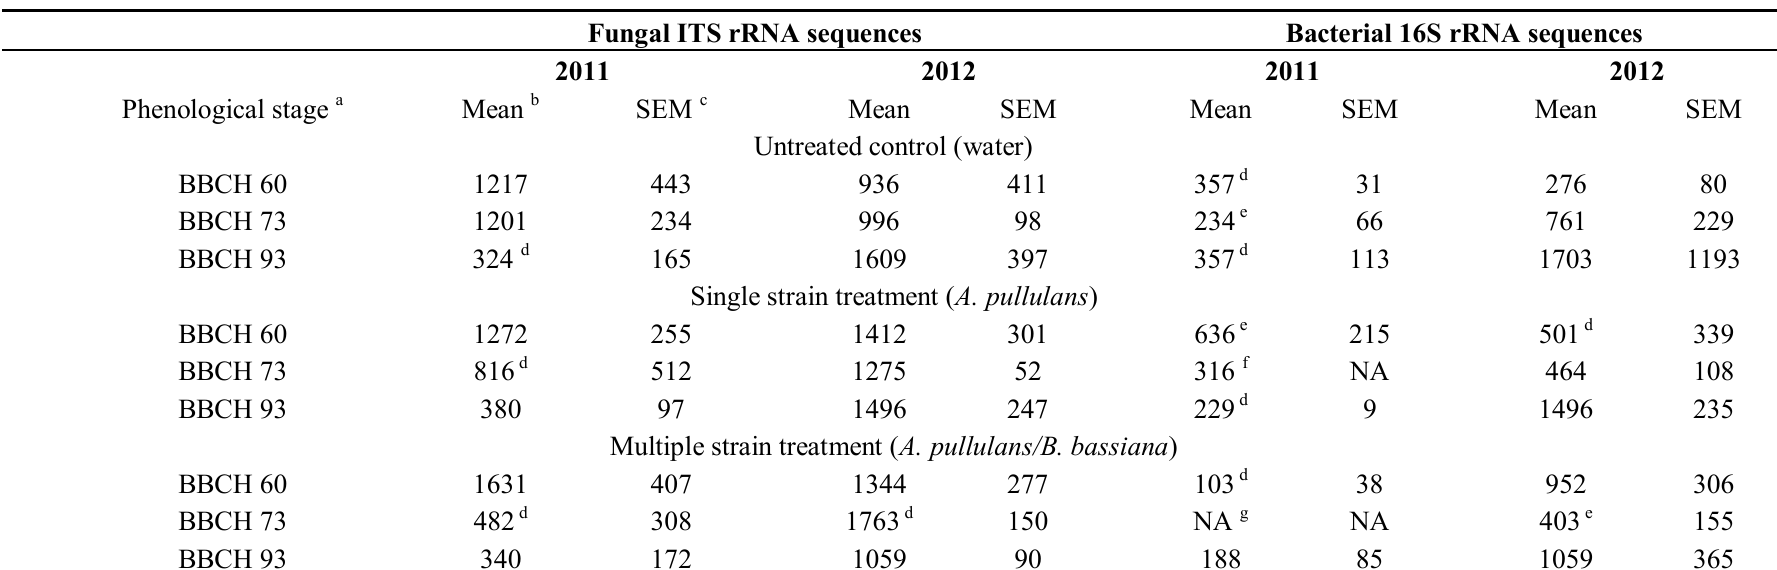
Table 1. Mean numbers of 454 pyrosequencing reads in differentially treated leaf samples obtained at different phenological stages in 2011 and